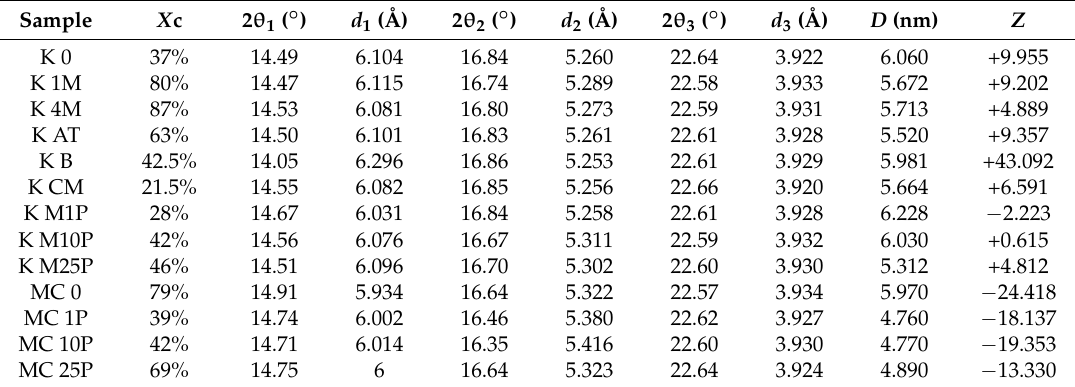
Table 1. XRD parameters: crystallinity degree ( X c), 2 θ values, interplanar distances ( d ), and Z criterion.